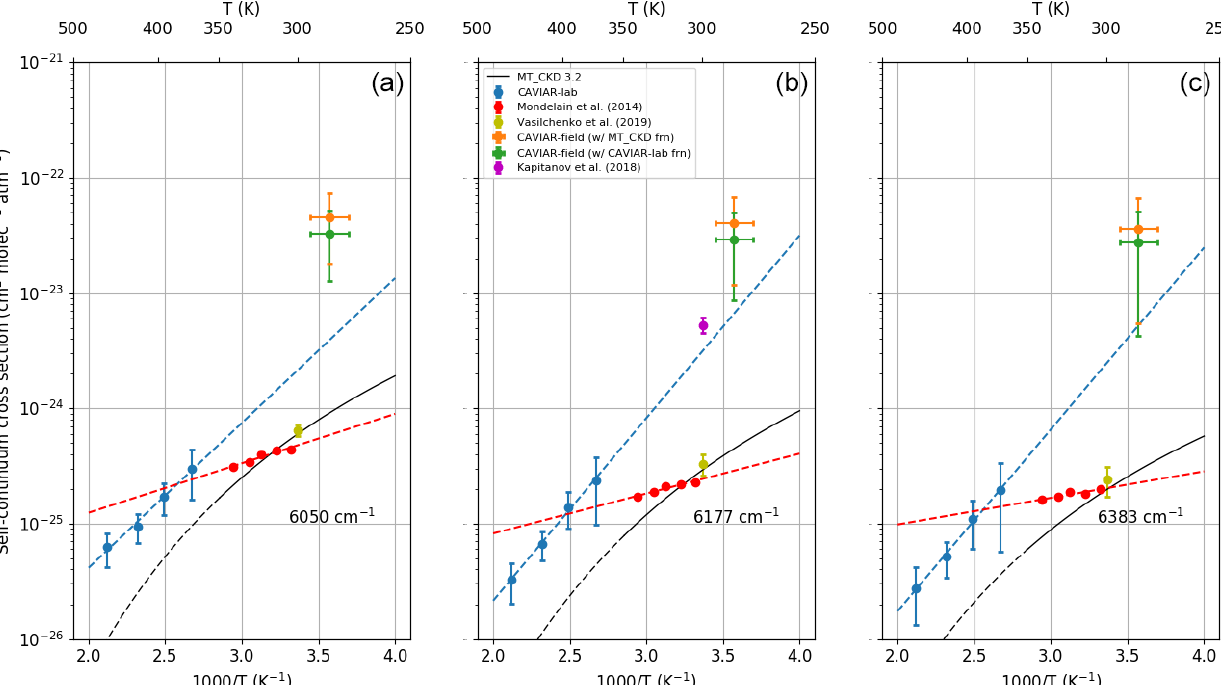
Figure 15. Self-continuum absorption cross section against temperature for various datasets at (a) 6050, (b) 6177, and (c) 6383cm − 1 . The error bars indicate the k = 1 uncertainties. Marker size is greater than the stated uncertainty where error bars are not visible. The dashed black line indicates the region outside of the expected applicability of MT_CKD. The dashed blue and red lines indicate extrapolations of the CAVIAR-lab and Grenoble temperature dependence